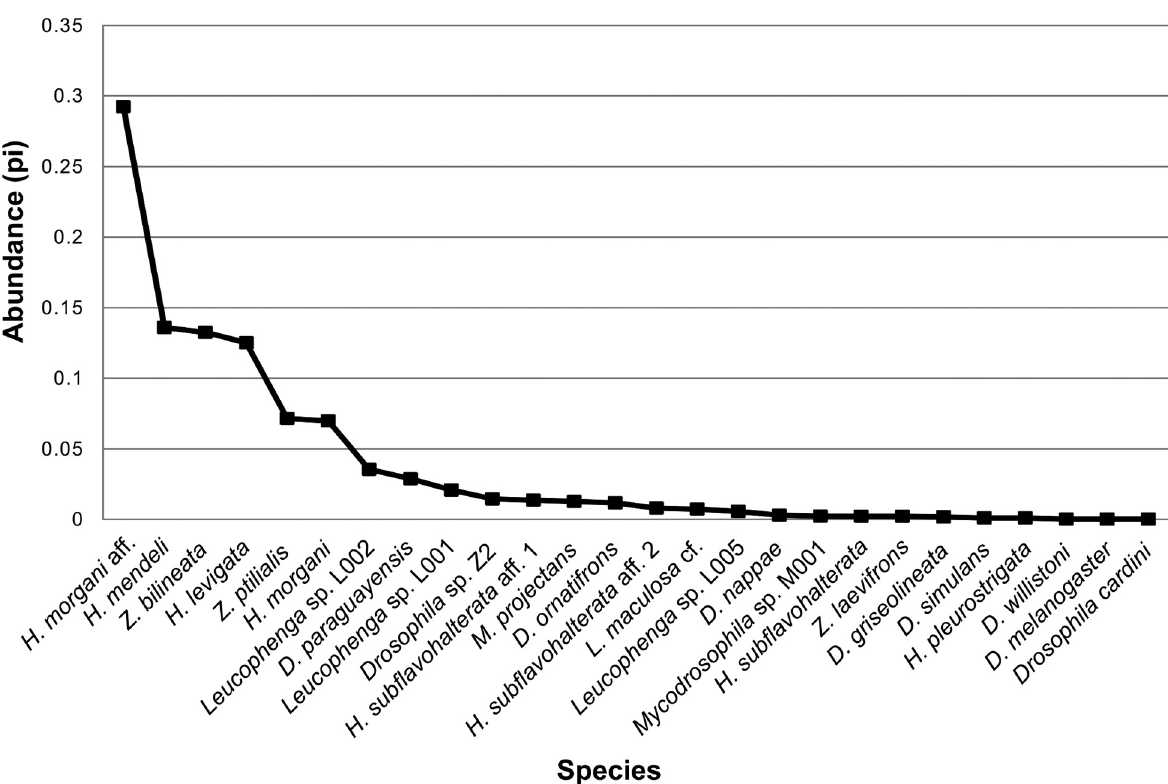
Figure 3 - Whittaker plot of relative abundance (pi) of emerged drosophilid from Basidiomycetes fungal species in Horto Botânico Irmão Teodoro